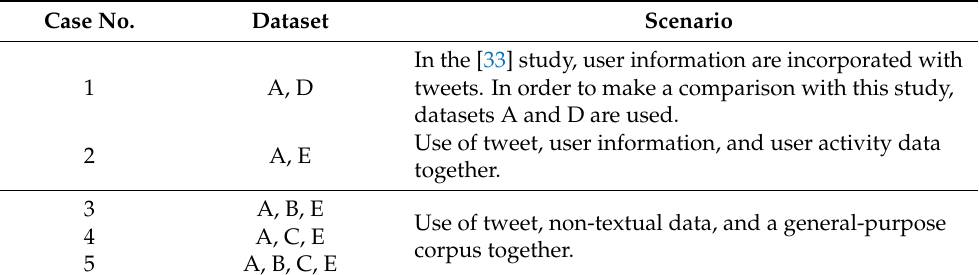
Table 7. Experimental setup